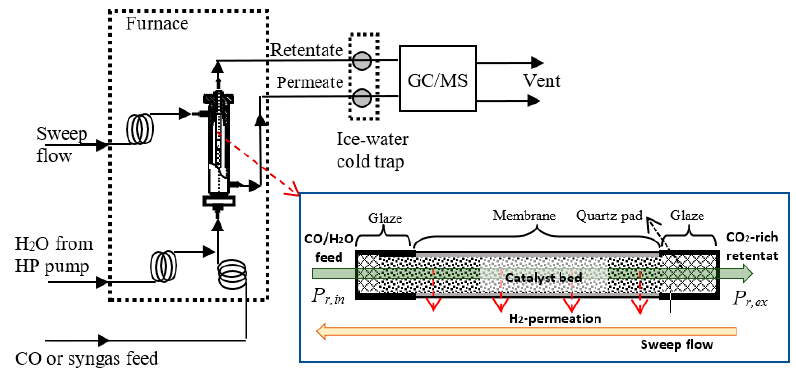
Figure 10. Schematic diagram of the WGS MR reaction system with an insert depicting the catalyst packing structure and countercurrent gas flow configuration.